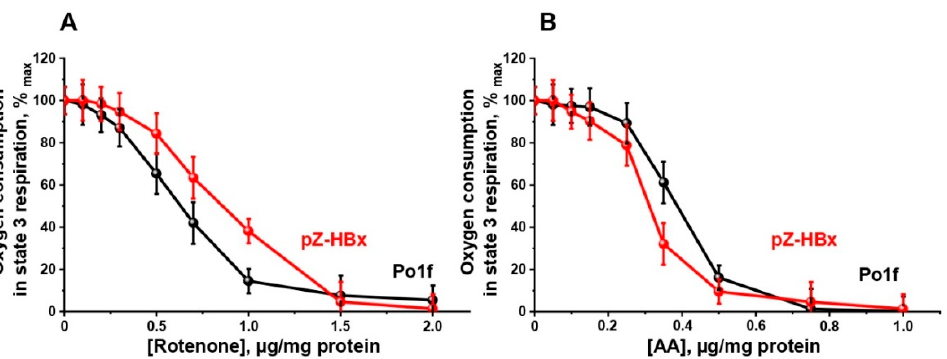
Figure 6. Amperometric recording of oxygen consumption by Y . lipolytica mitochondria in state 3 respiration as affected by respiratory inhibitors: rotenone ( A ) and antimycin ( B ). Incubation medium was supplemented with 1 mM ADP and mitochondria (0.5 mg protein/mL). In good agreement with the above data, mitochondria from the HBx-expressing mutant were much more sensitive to the action of a depolarizing agent (palmitate) than mitochondria of the control variant (Figure 7).